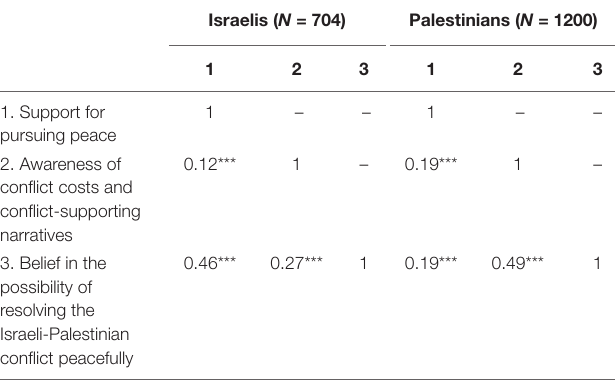
TABLE 2 | Bivariate correlations among Study 1